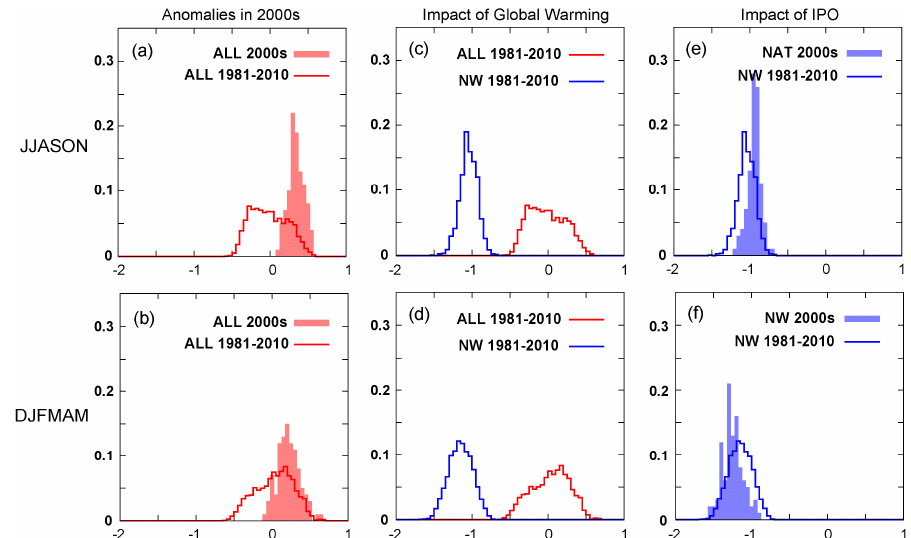
Figure 5. Histograms of 12-year-mean Japanese land surface temperature anomalies of JJASON ( a , c , e ) and DJFMAM ( b , d , f ). The histograms are normalized by each sample number. Open columns are for each 12 year window from 1981 to 2010, and filled columns are averaged from 1999 to 2010. Red (blue) is results from the ALL (non-warming; NW) run. ( a and b ) comparison of 1999–2010 with 1981–2010 based on the ALL run, ( c and d ) comparison of ALL with NW, ( e and f ) comparison of 1999-2010 with 1981–2010 based on the NW run.